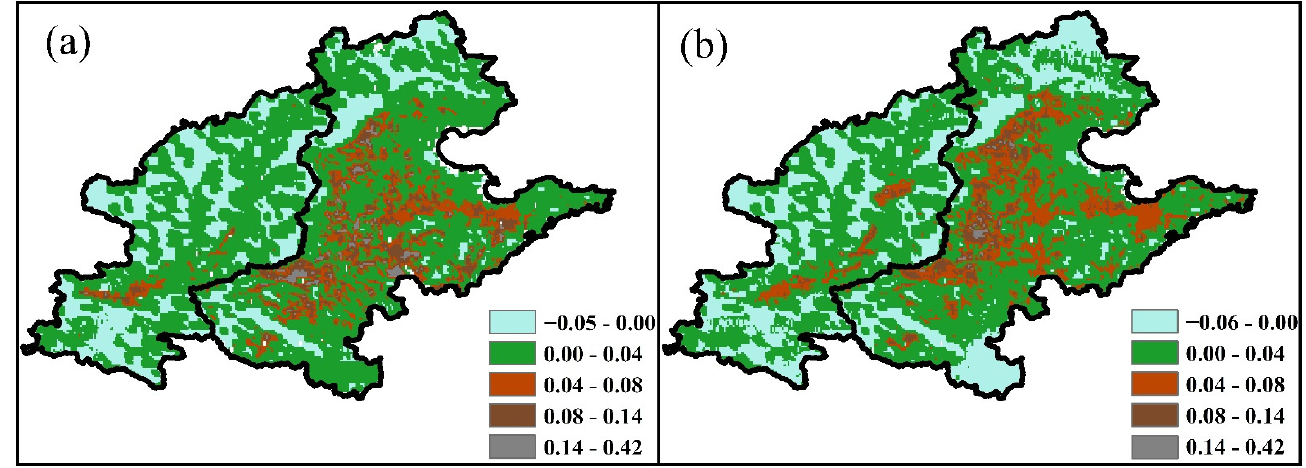
Figure 7. The correlation coefficient difference values of winter wheat ( a ) and summer maize ( b ) response degree to drought (between the SPEII and SPEI).